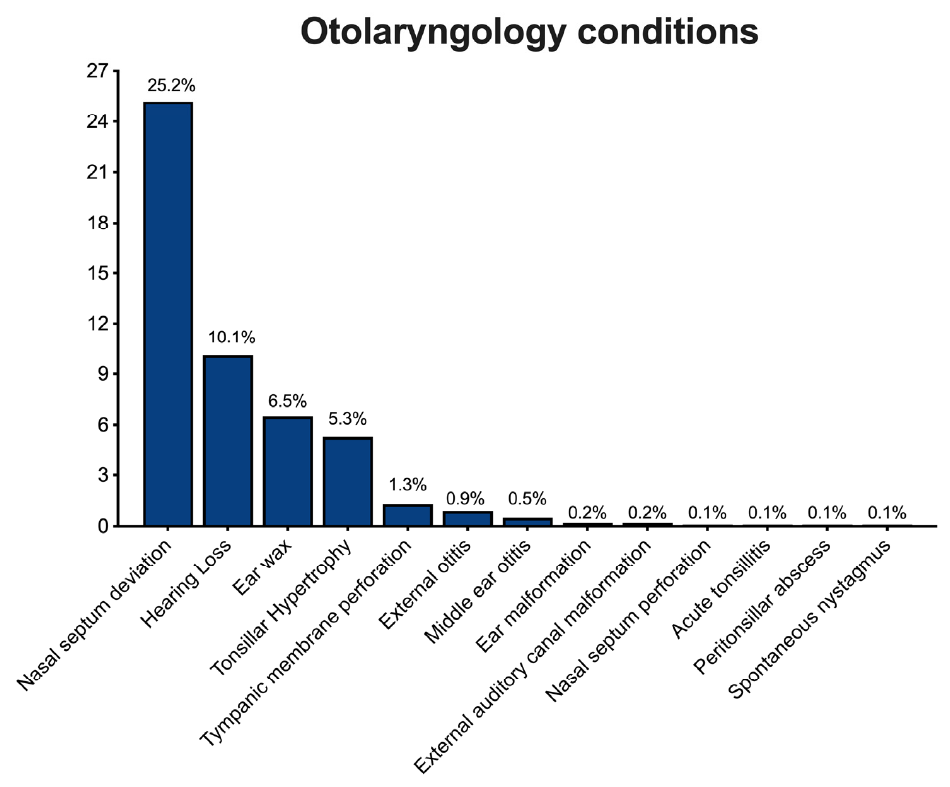
Figure 3. Histogram of otolaryngological conditions found during the clinical examination. Data above each column were rounded to the first decimal.